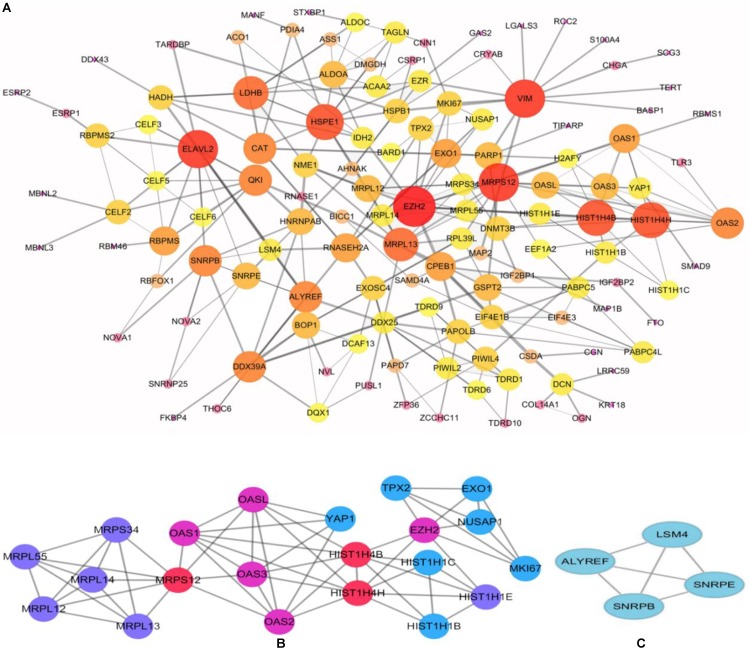
Construction of protein-protein interaction (PPI) network. (A) Modules inferred from protein-protein interaction network. Elected important modules of target gene (B,C) MCODE score >4, nodes >4.